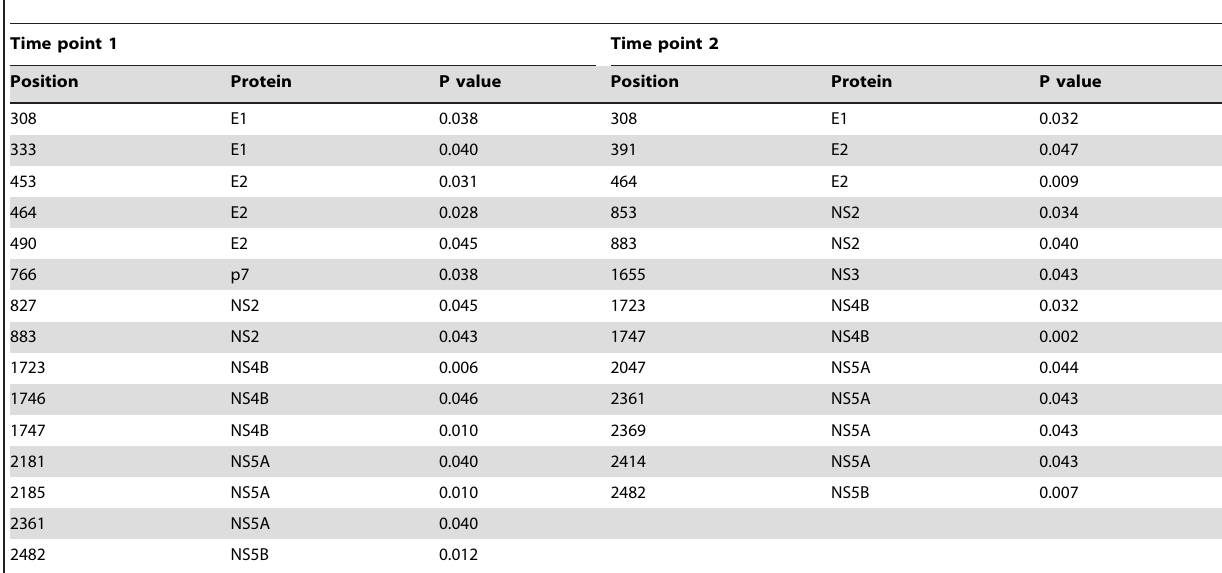
Table 7. Positions where the distribution of amino acids differ between the rapid and slow progressor